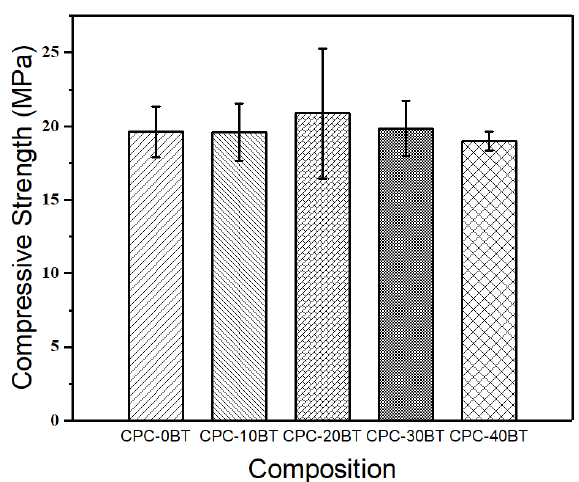
Figure 1. Compressive strengths of different compositions of smart calcium phosphate bone cements (CPCs).